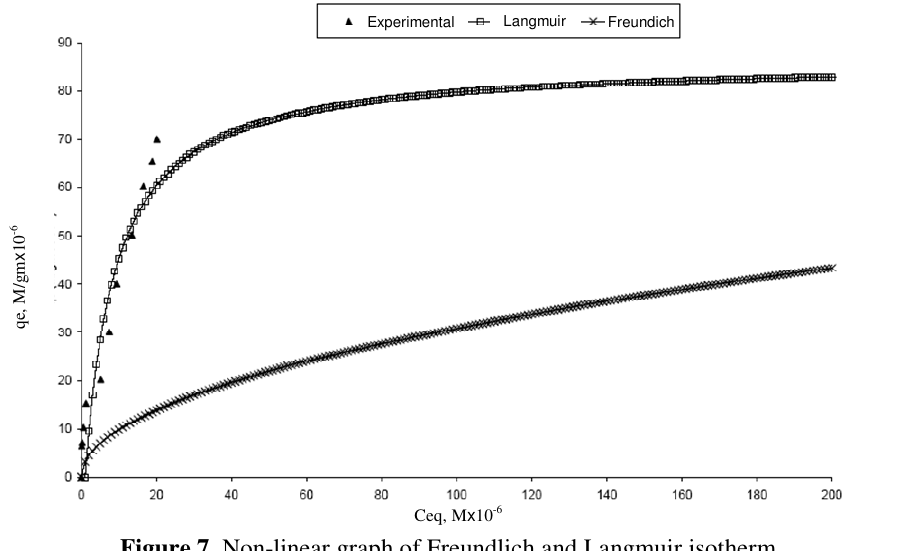
Figure 7. Non-linear graph of Freundlich and Langmuir isotherm. Table 1. Isotherm parameters for adsorption of CV onto TSP. Freundlich Isotherm Langmuir Isotherm Temperature, K